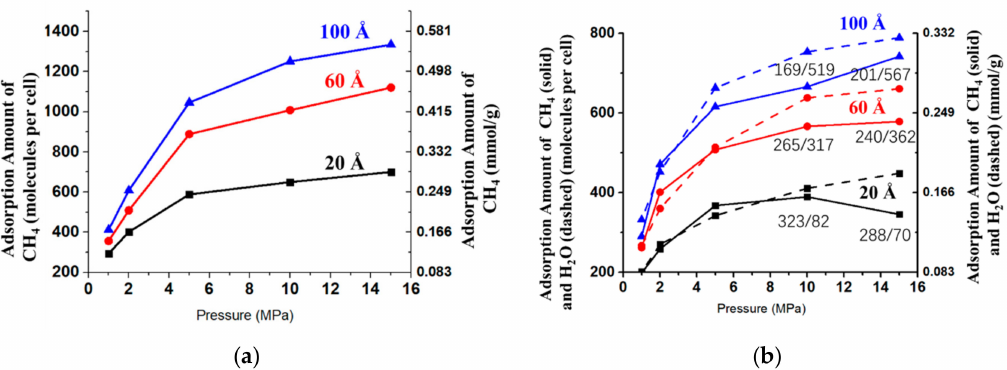
Figure 4. Adsorption isotherms of ( a ) CH 4 and ( b ) CH 4 and H 2 O in the coalbed model. Blue, red, and black lines refer to the models with 100 Å, 60 Å, and 20 Å pore sizes, respectively. For convenience, the adsorption amounts are measured in units of both the number of molecules per cell and mmol / g (by assuming that the coal has a specific surface area of 50 m 2 / g). In ( a ), CH 4 is the only adsorbate. In ( b ), both CH 4 (solid lines) and H 2 O (dashed lines) with equal fugacity are adsorbed in the